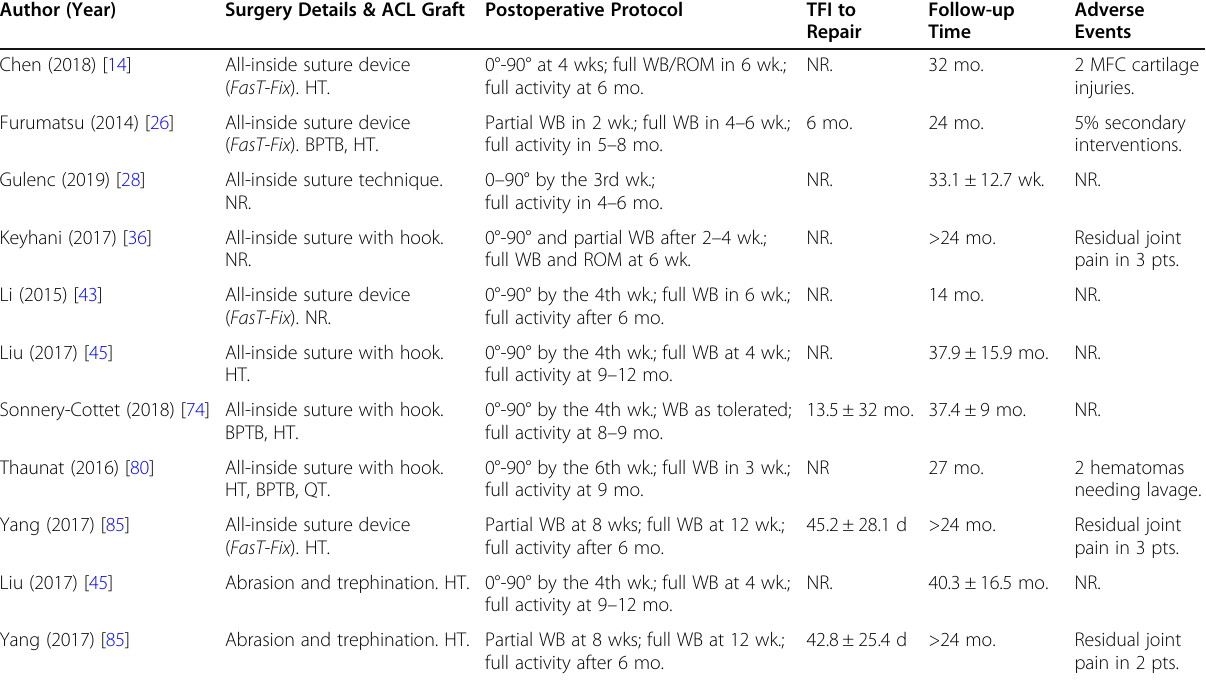
a ACL Anterior Cruciate Ligament, BTB bone-tendon-bone autograft, d days, MFC medial femoral condyle, mo months, HT hamstring tendon autograft, NR not reported, pts patients, QT quadriceps tendon autograft, ROM range of motion, TFI time from injury, WB weight-bearing, wk